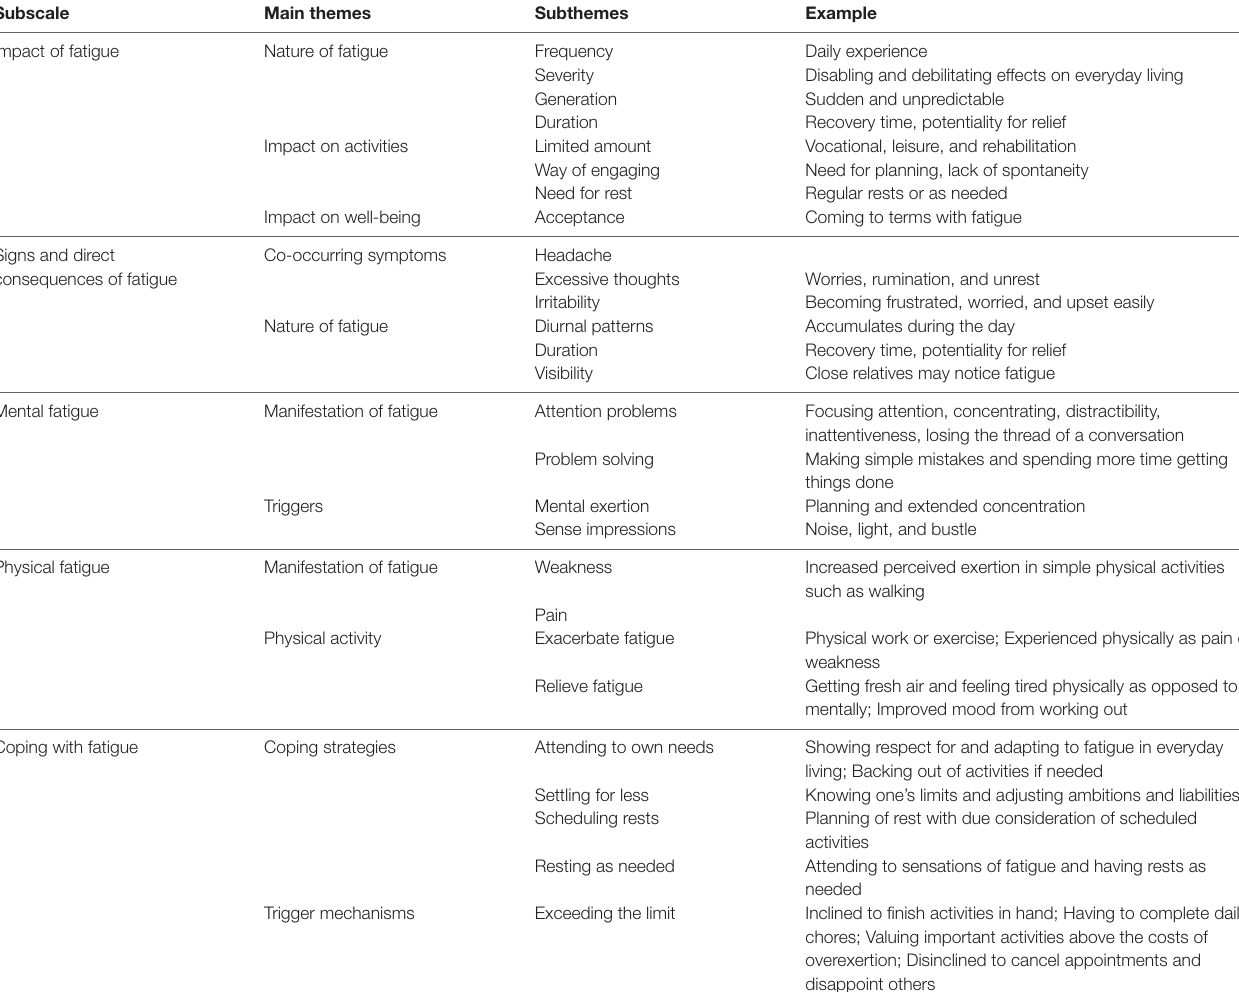
TABLE 4 | Themes identified within subscales in synthesis of congruent response processes to items of the Danish version of the Dutch Multifactor Fatigue Scale.